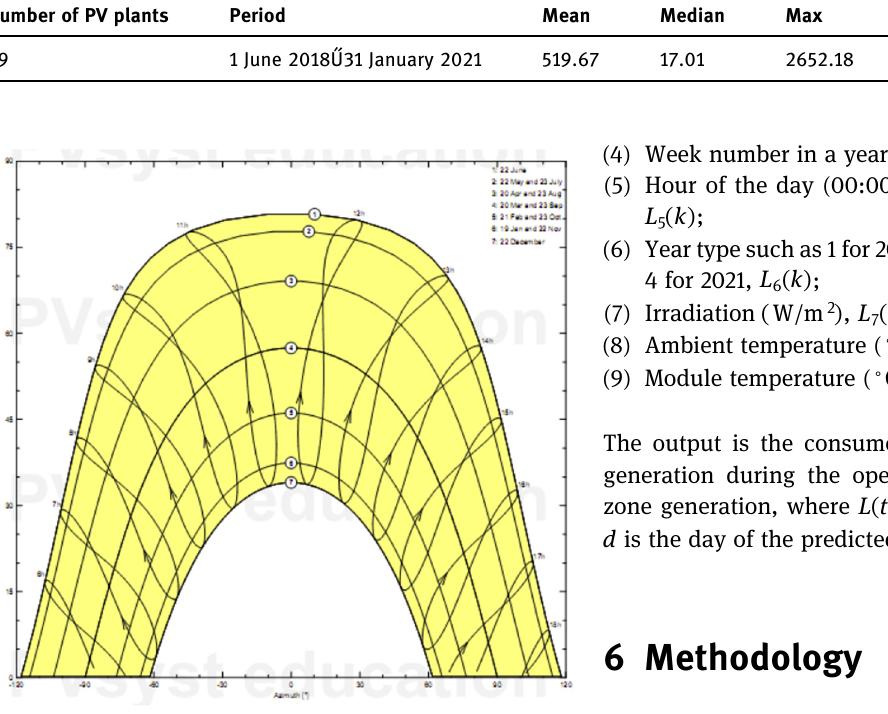
Figure 2: Solar paths at Yarmouk University location.